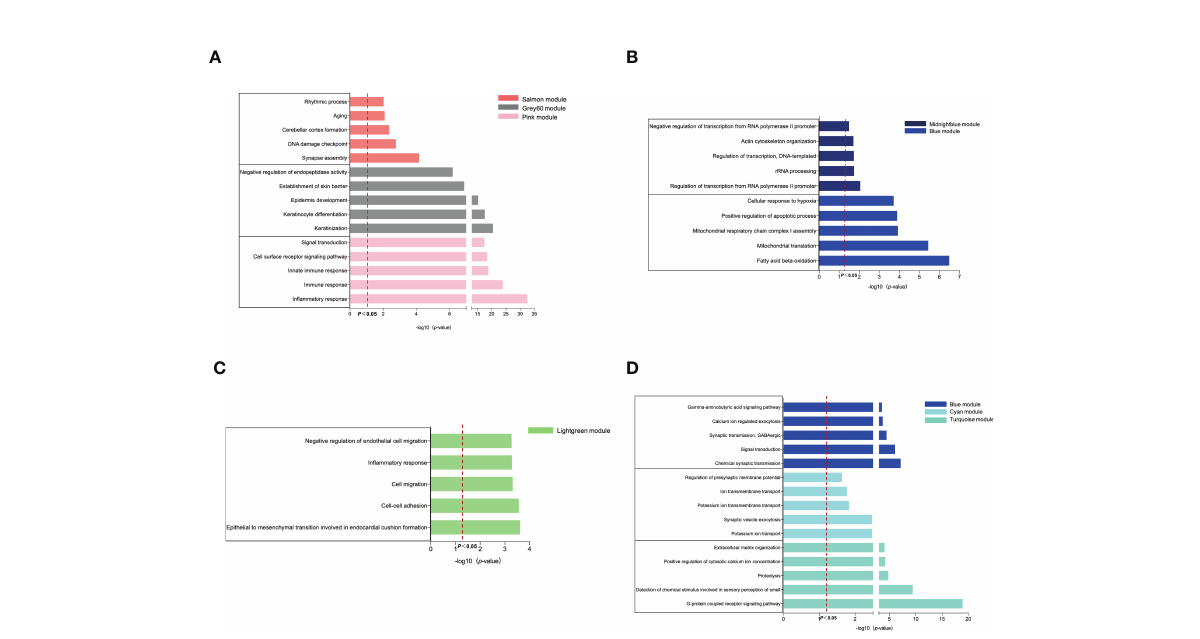
FIGURE 2 GO enrichment analysis of the modular genes. (A) The GO biological process analyses of three positive OB-related modules. (B) The GO biological process analyses of two negative OB-related modules. (C) The GO biological process analyses of one positive AD-related modules. (D) The GO biological process analyses of three negative AD-related modules. OB, obesity; AD, Alzheimer ’ s disease; GO, gene